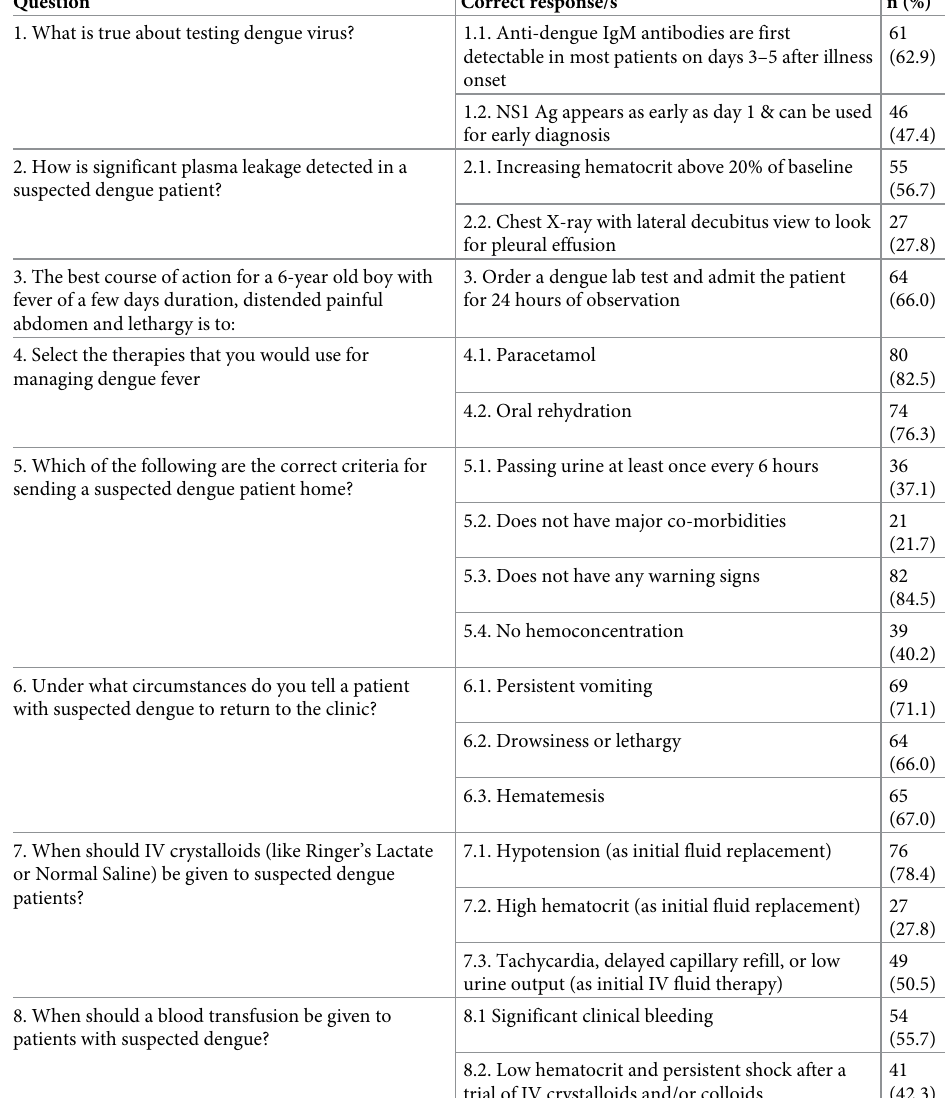
Table 4. Knowledge on diagnosis and management of dengue (domain 3), Bhutan, 2019–2020.